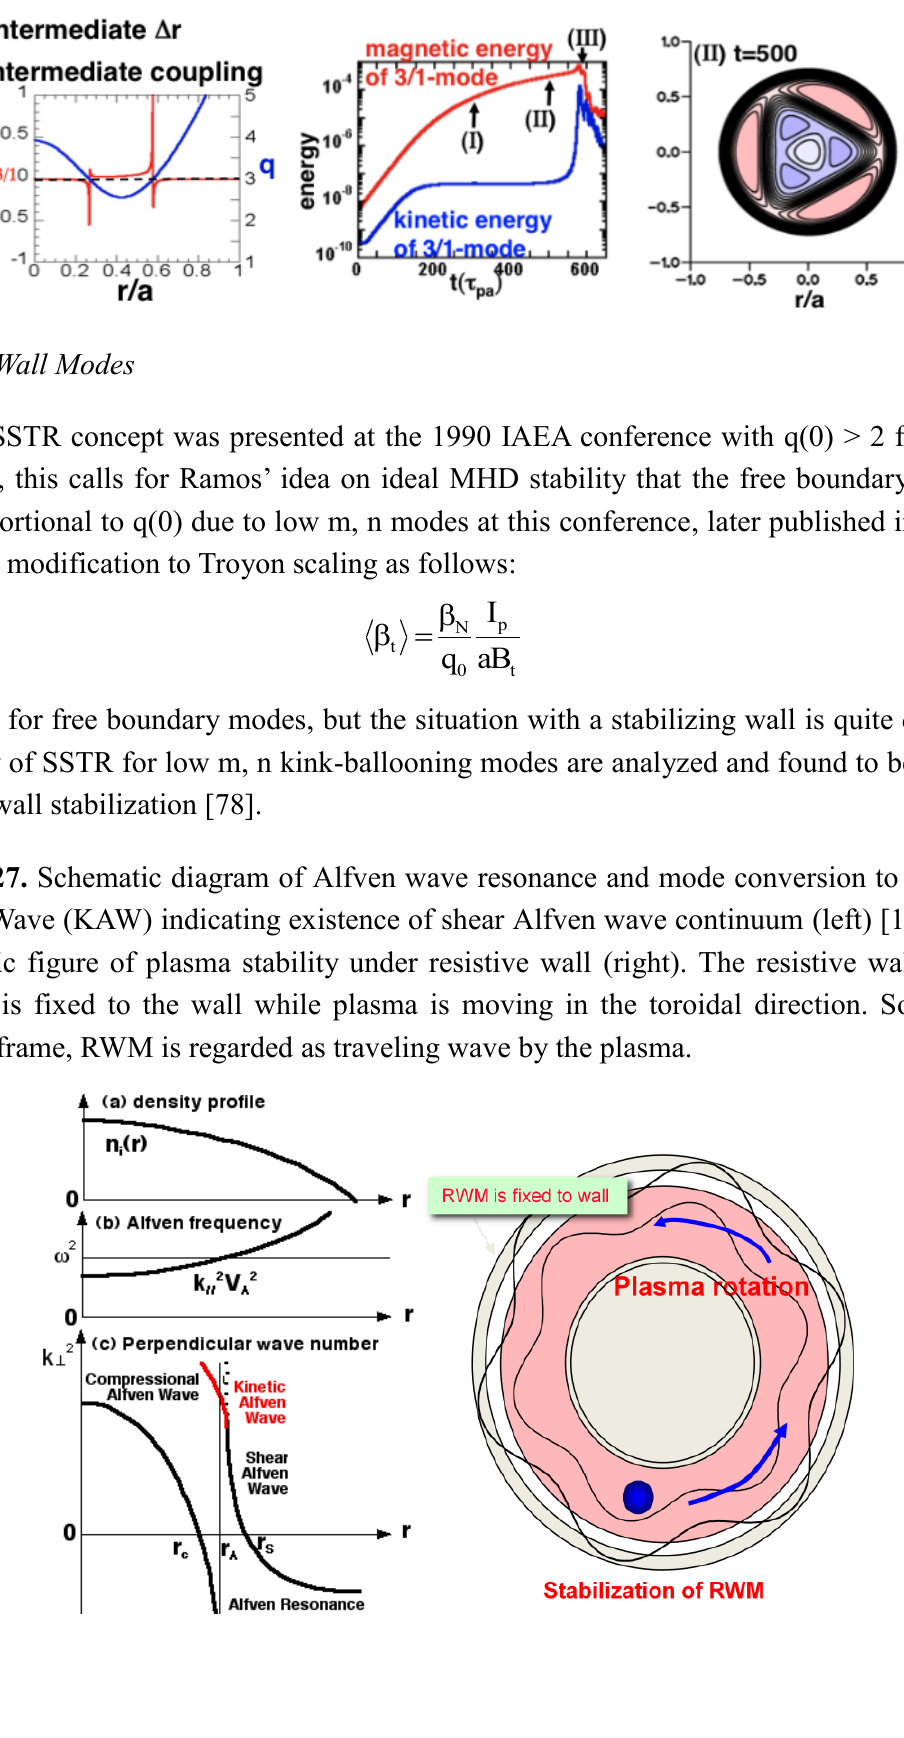
Figure 26. DTM linear mode structure for intermediate separation of rational surfaces (left), time evolution of magnetic and kinetic energies in nonlinear DTM simulation (middle) and magnetic island before explosive growth (right) [131].